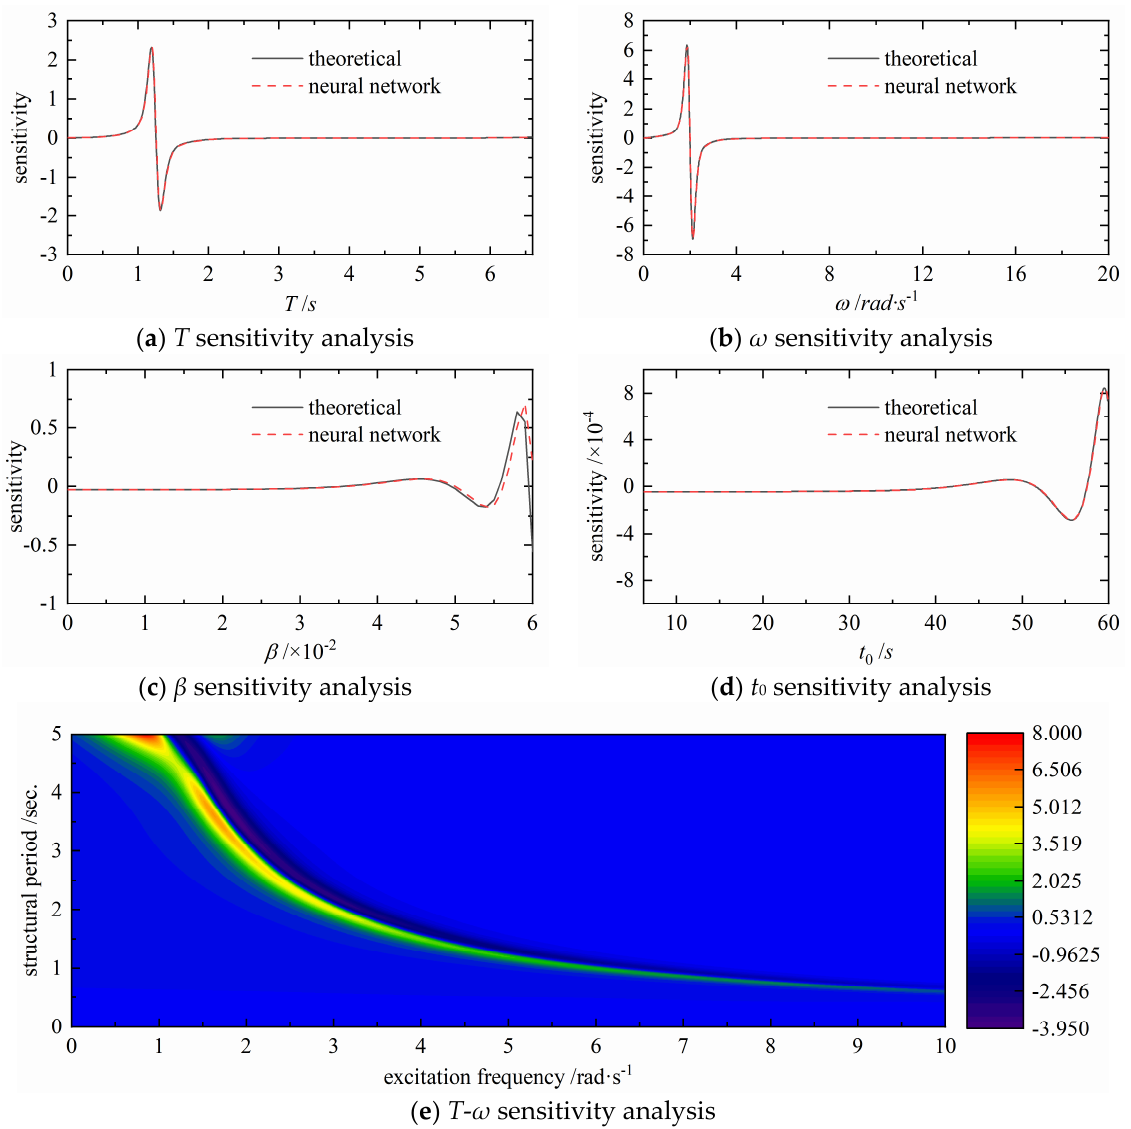
Figure 10. Sensitivity analysis of input parameters.